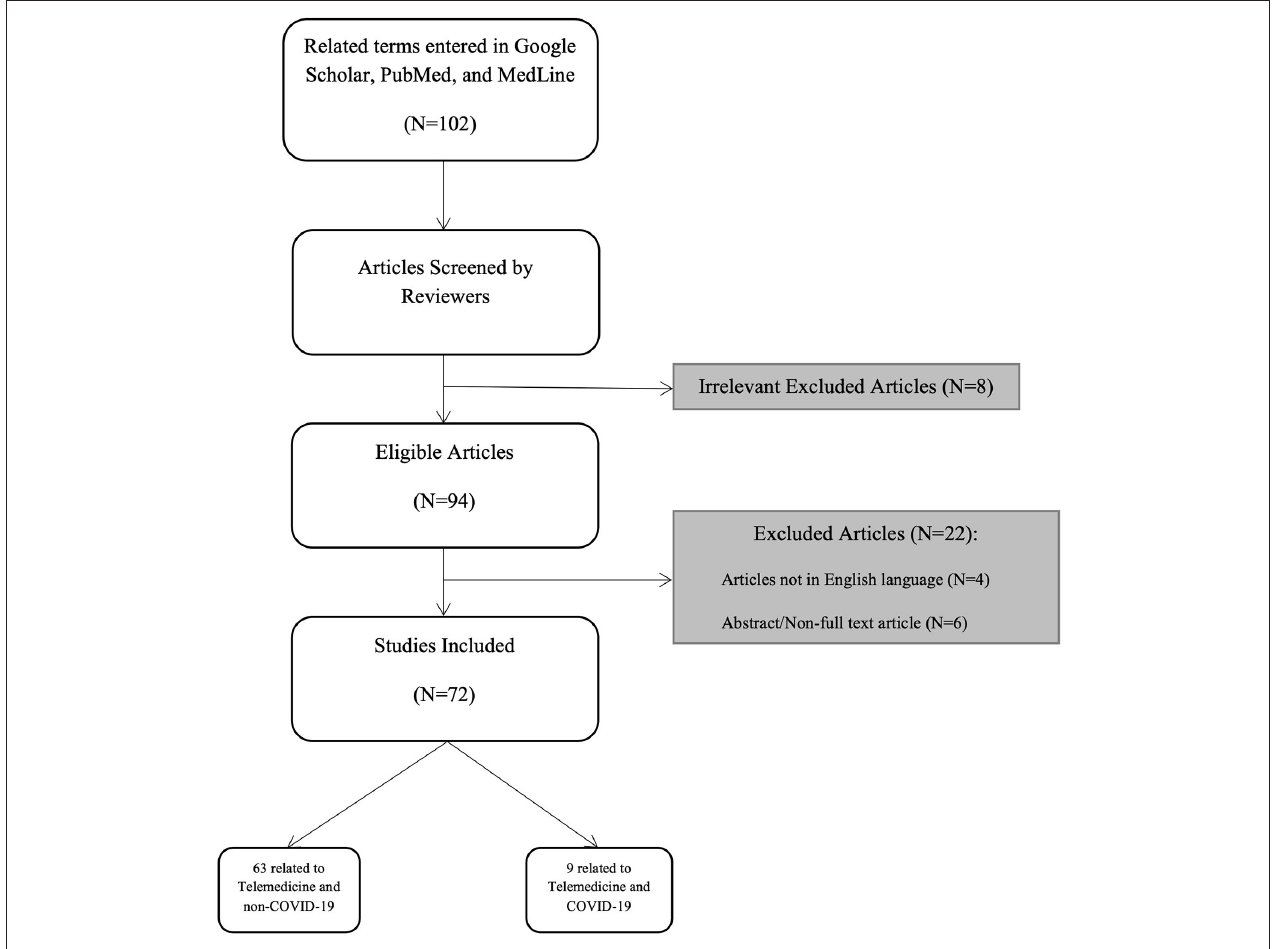
FIGURE 1 | Flowchart illustrating the search strategy used in this